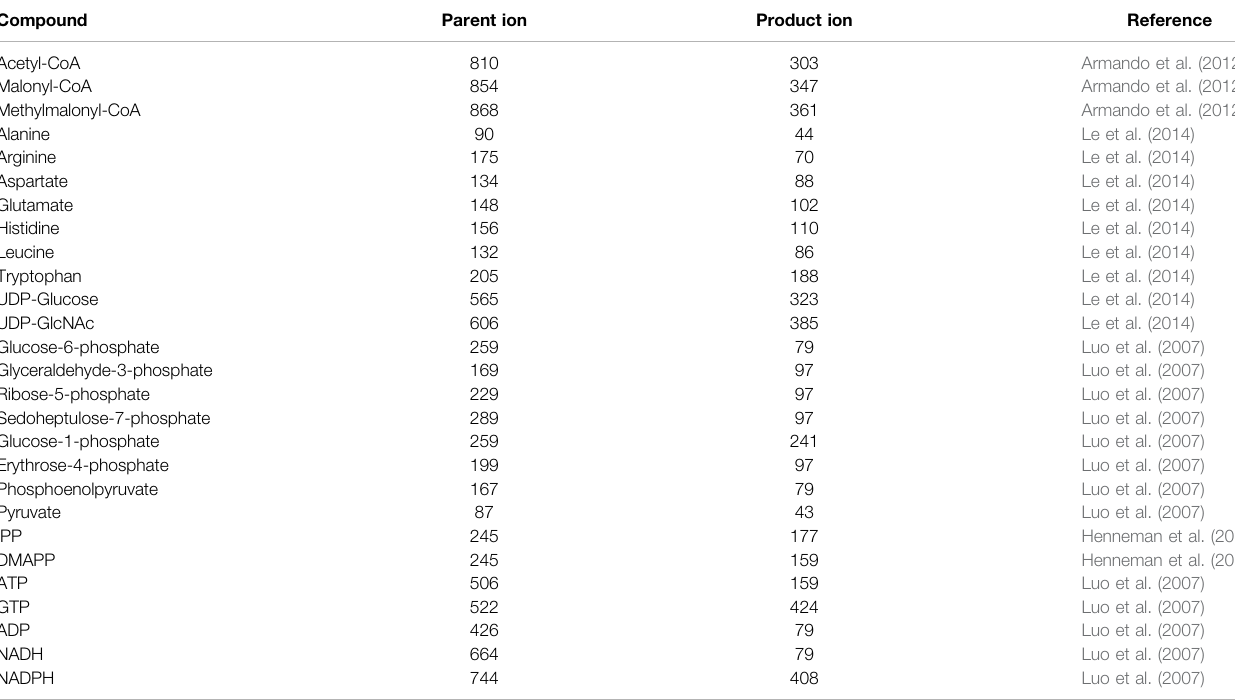
TABLE 2 | Ion-pairing for MRM-based LC-MS/MS detection of some metabolites. Compound Parent